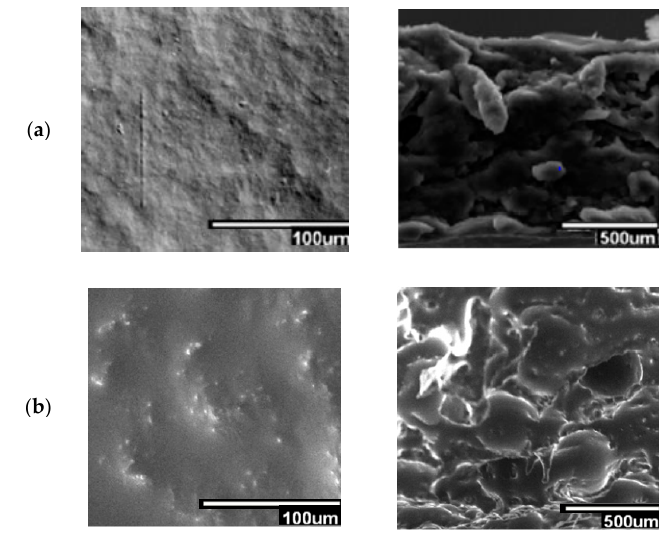
Figure 2. SEM Photos of ( a ) TM-PEC %0.4 ( b ) TM-PEC %1: Surface (left) and cross section (right).